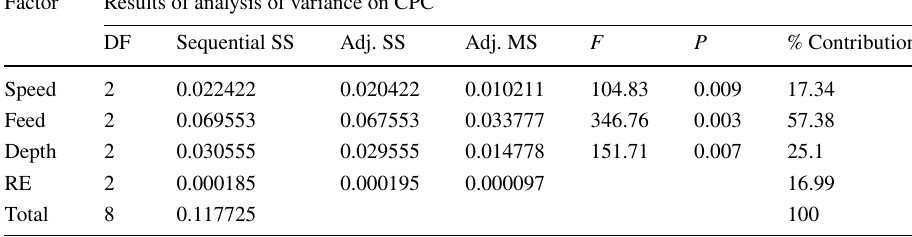
Factor Results of analysis of variance on CPC DF